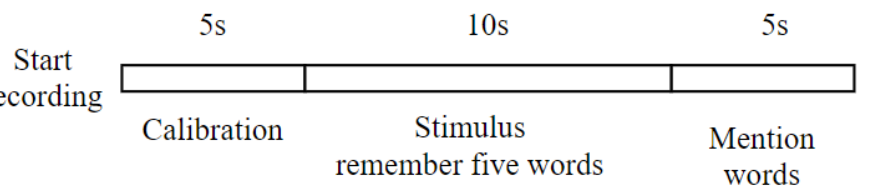
Figure 3. EEG recording of memory, starting with calibration to ensure the condition of the electrodes and then continuing with the stimulus.